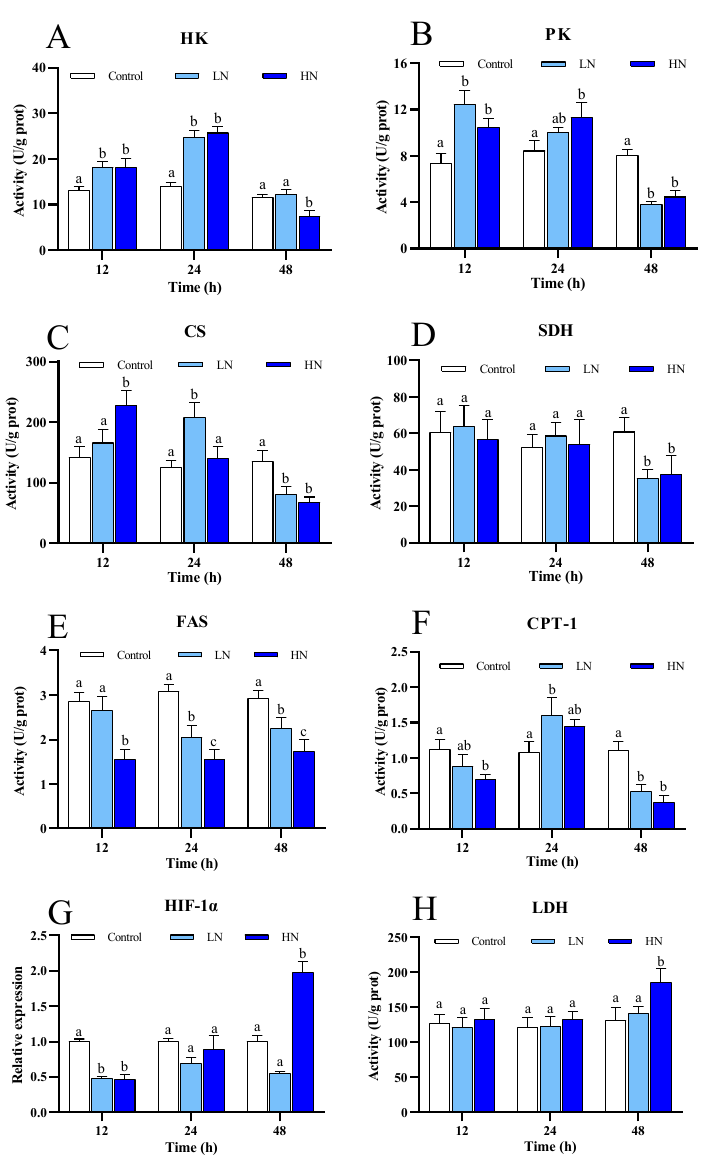
Figure 3. The enzymes activities of five enzymes and mRNA expression of HIF-1 α of juvenile P. trituberculatus under nitrite stress. ( A ) The enzyme activities of HK, ( B ) the enzyme activities of PK, ( C ) the enzyme activities of CS, ( D ) the enzyme activities of SDH, ( E ) the enzyme activities of FAS, ( F ) the enzyme activities of CPT-1, ( G ) mRNA expression of HIF-1 α , and ( H ) the enzyme activities of LDH. At each time point, the letters indicate significant differences between experimental groups ( p < 0.05).